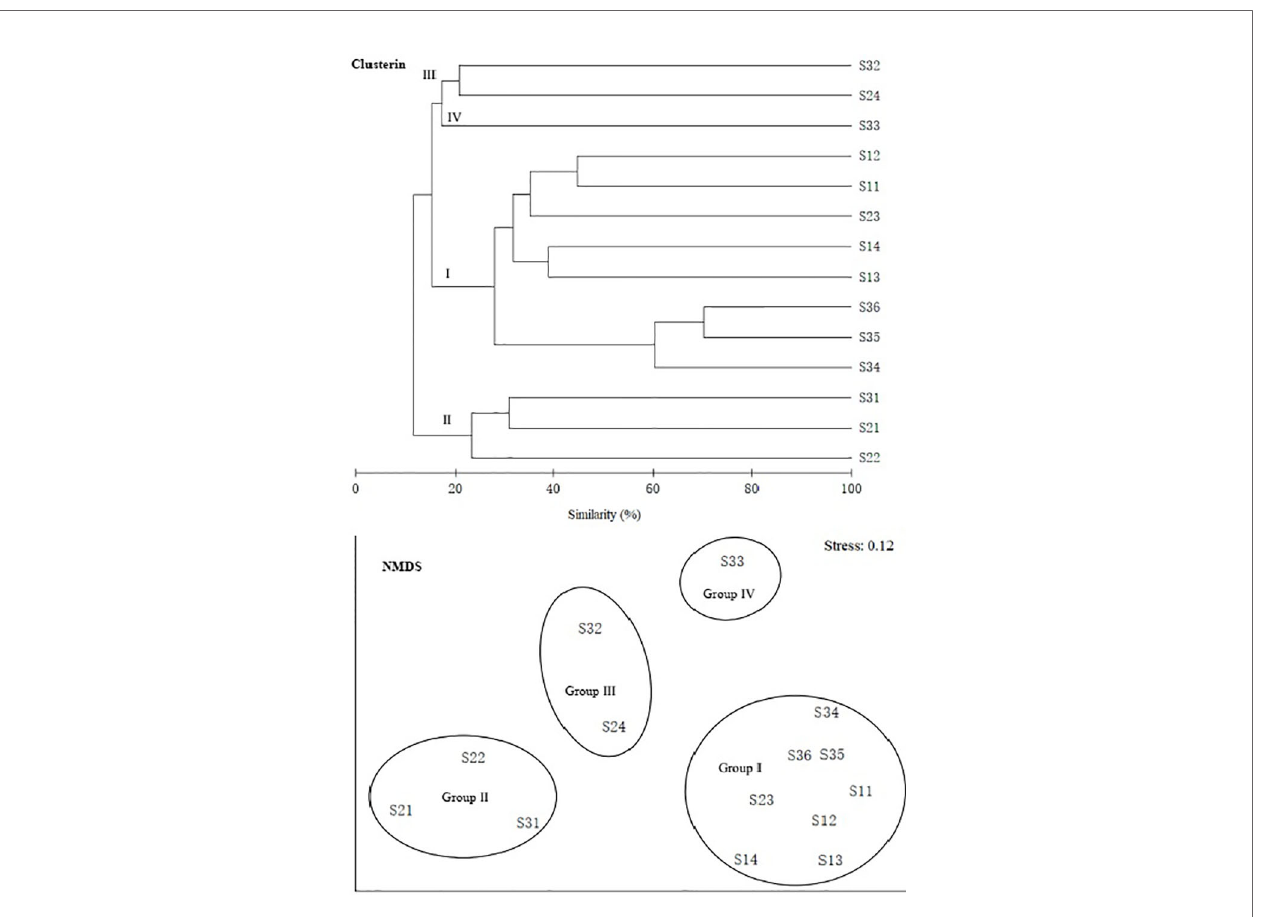
FIGURE 8 | Group average clustering and non-metric multi-dimensional scaling (NMDS) among family of demeral fi sh over the NCSSCS.